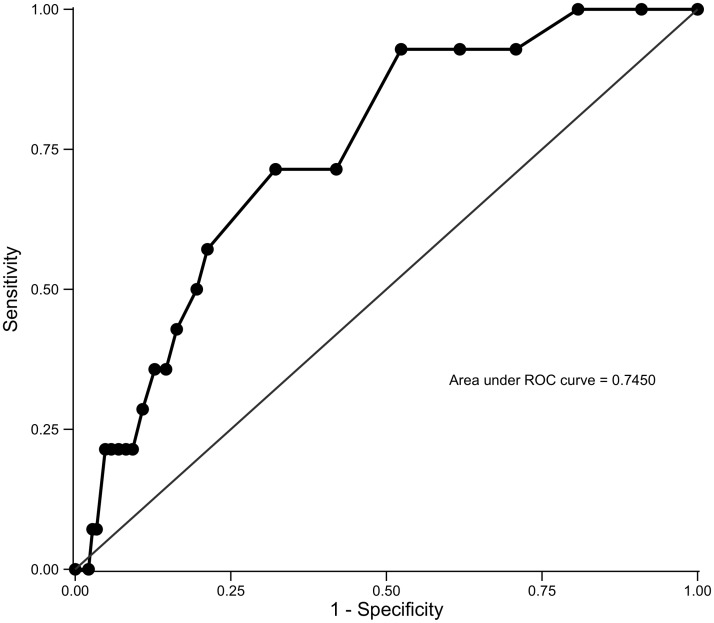
Receiver Operating Characteristics (ROC) Curves of Generalized Anxiety Disorder 7-Item (GAD-7) Scores.